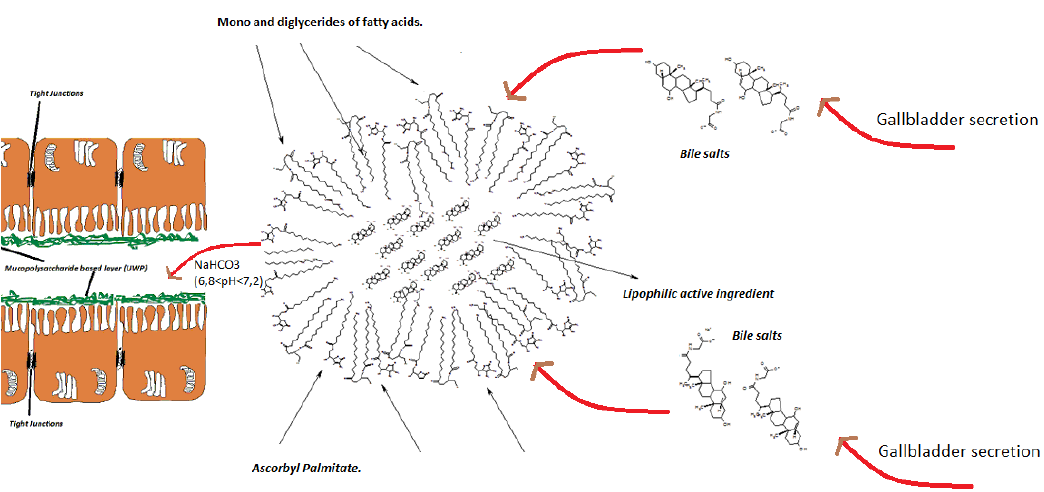
Figure 7. Representation of Lipomatrix mechanism of delivery: lipophilic molecule entrapped in a mixed micellar structure composed of MDGFA, ASP, and bile salts.